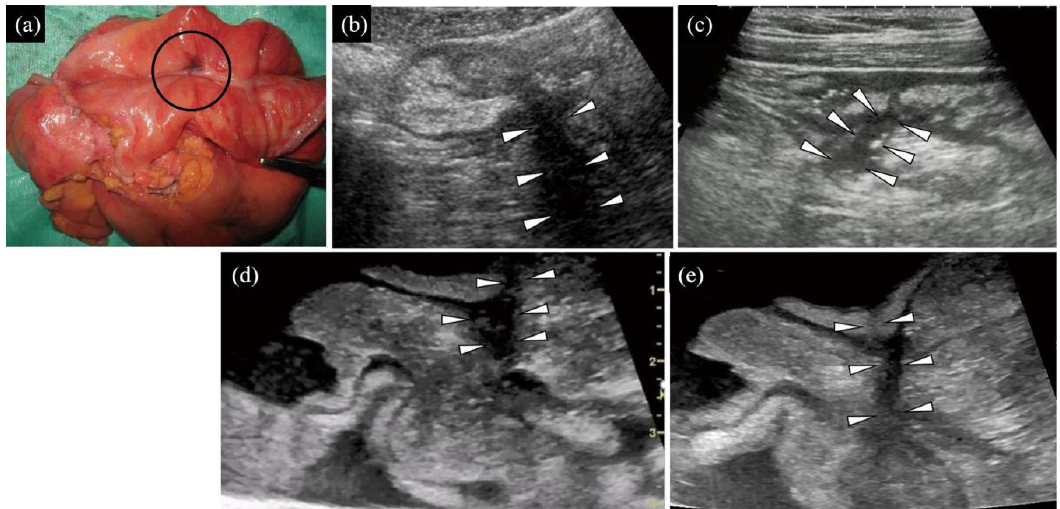
Figure 5. Openly longitudinal ulcer and internal fistula of the ileum. ( a ) Gross morphology findings. The black circle shows the location of the scanning area. ( b , c ) Transverse ( b ) and longitudinal ( c ) view by TAUS. ( d , e ) Transverse view by WIUS (open view). The findings of WIUS and TAUS are similar. Wall stratification of the submucosal and mucosal layers has disappeared. Because the wall stratification has disappeared, it is not possible to determine whether the submucosal layer is thickened. WIUS and TAUS detected irregularities in the mucosal surface. In the transverse view, TAUS ( b ) and WIUS ( d , e ) show that fat wrapping does not reach two-thirds of the circumference of the intestine. A tubular hypoechoic structure passes through and extends out of the intestinal wall (arrowhead). It is worth noting that the intestinal wall, where the tubular hypoechoic structure is located, is disorganized and indistinguishable from surrounding tissue. The intestinal canal is pulled and deformed. This abnormality is considered as an intestinal adhesion caused by chronic inflammatory changes around the fistula. For this lesion, TAUS and WIUS consistently determined the following US parameters: (1) disappearance of the submucosal and mucosal layers; (2) because the stratification disappeared, submucosal layer thickening could not be determined; (3) irregularity of the mucosal surface; (4) increased fat wrapping around the bowel wall was not detected; and (5) presence of fistula signs.